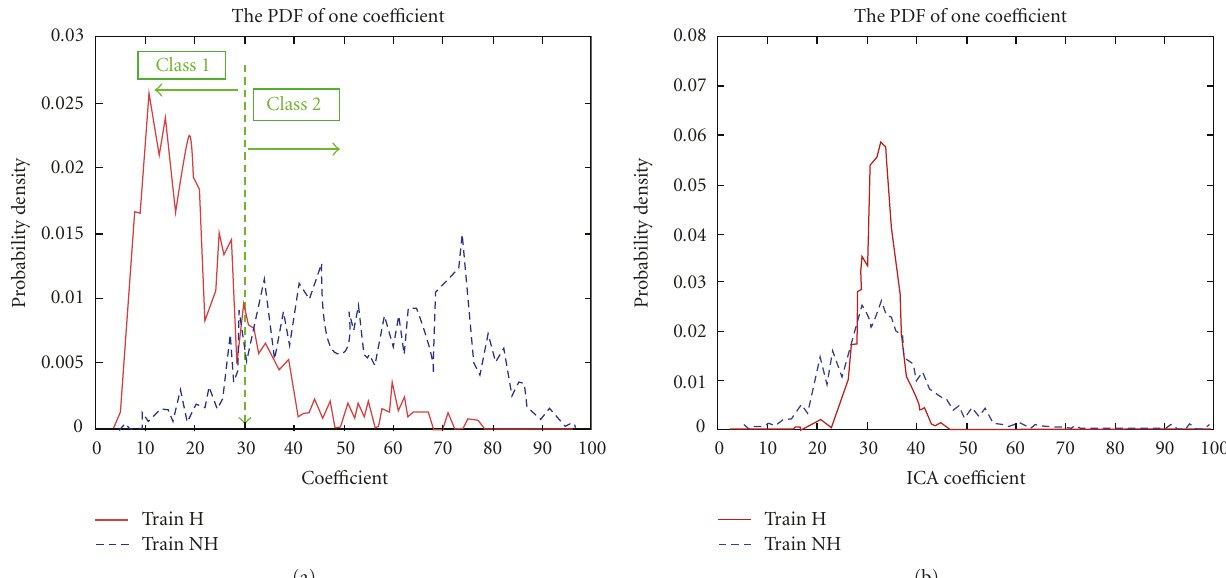
Figure 9: Di ff erent distributions of ICA coe ffi cient in (a) the ideal case and (b) the real case.